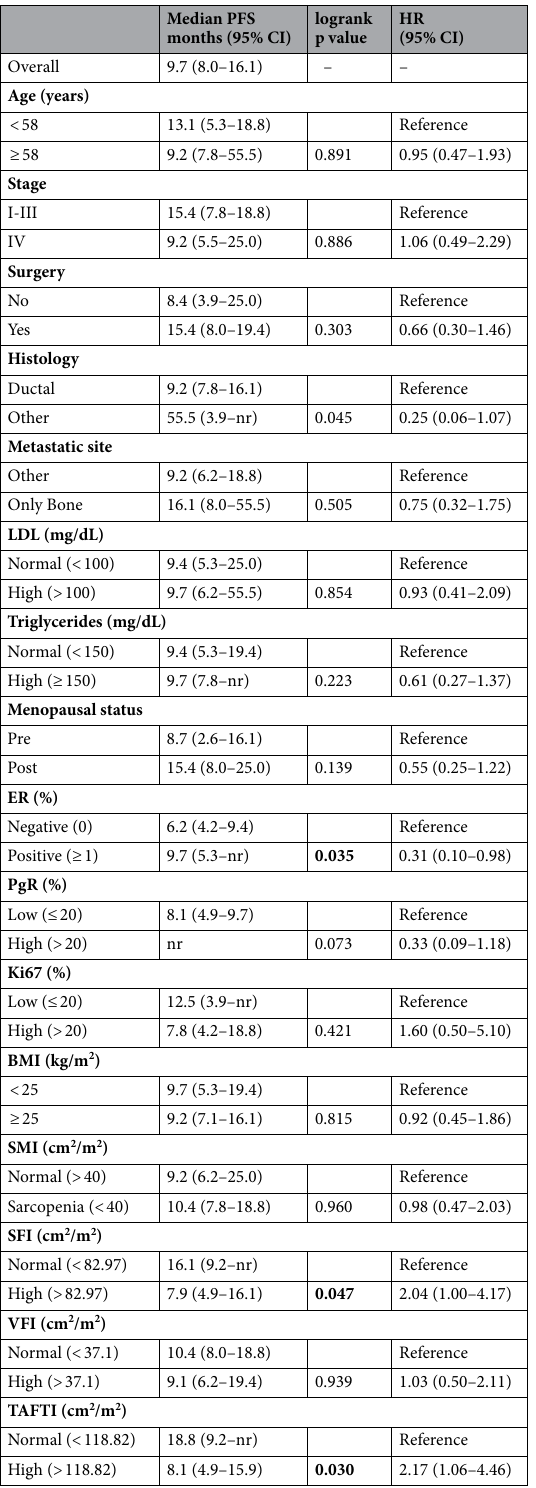
Table 2. Univariate analysis results for all the parameters considered in the study. Significant values are in bold. PFS progression-free survival, HR hazard ratio (from Cox regression models), CI confidence interval,